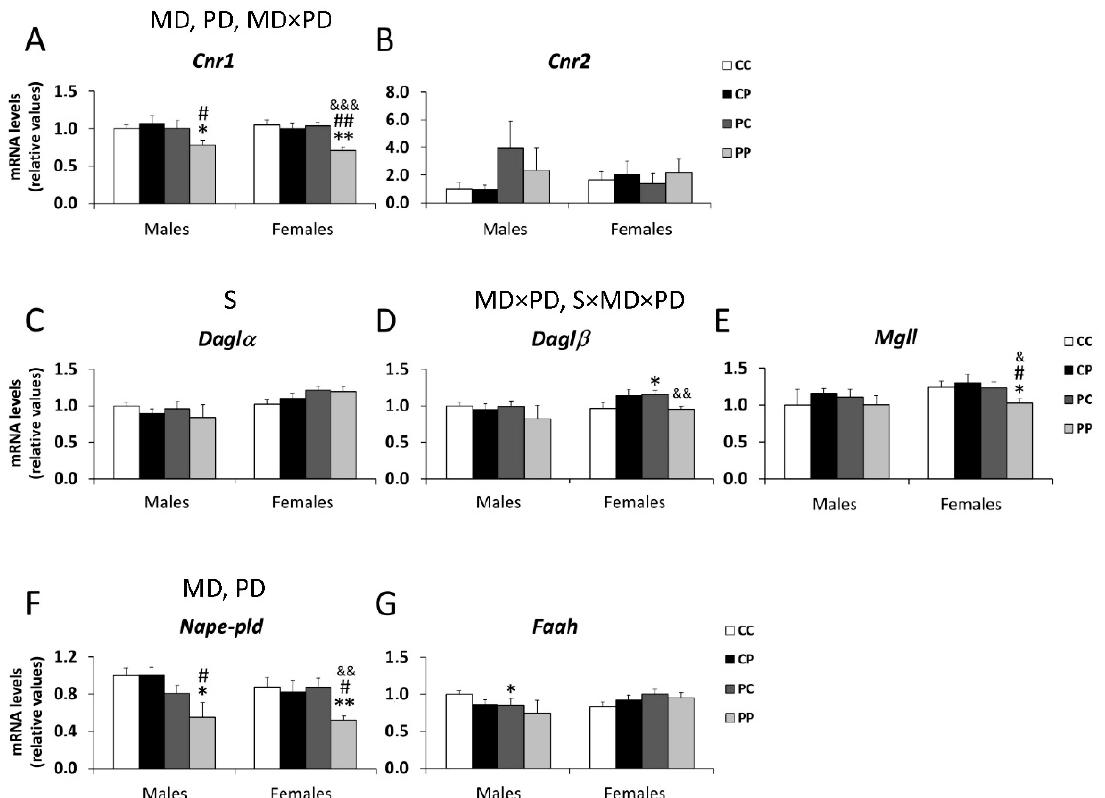
Figure 3. E ff ect of maternal and / or o ff spring exposure to a free-choice palatable (P) diet on the relative mRNA levels of endocannabinoid system genes: Cnr1 ( A ), Cnr2 ( B ), Dagl α ( C ), Dagl β ( D ), Mgll ( E ), Nape-pld ( F ) and Faah ( G ) in the prefrontal cortex of male and female o ff spring in adulthood. Data are expressed as the mean ± S.E.M. ( n = 6). Student´s t test: * / ** p < 0.05 / 0.01 vs. CC males or CC females; # / ## p < 0.05 / 0.01 vs. CP males or CP females; & / && / &&& p < 0.05 / 0.01 / 0.001 vs. PC males or PC females. MD: maternal diet e ff ect; PD: postnatal diet e ff ect; S: sex e ff ect; MDxPD: maternal and postnatal diets interaction; SxMDxPD: sex, maternal diet and postnatal diet interaction.